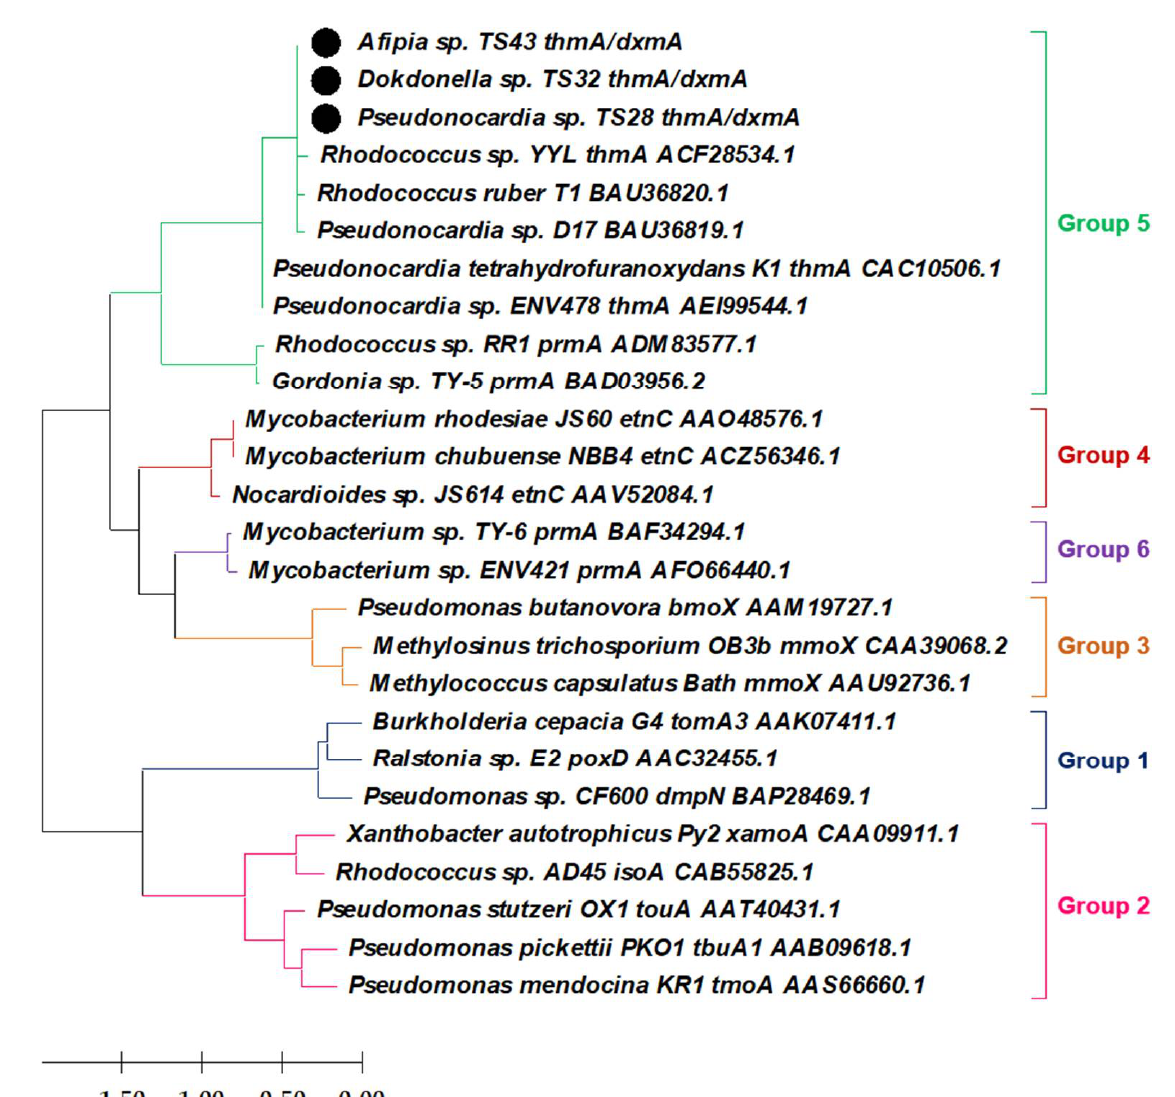
Figure 4. Phylogenetic relationships of SDIMO α -subunit genes (i.e., thmA/dxmA ) present on the chromosomes of the isolated strains (indicated by the black circles) and other SDIMO α -subunit genes as generated by the maximum likelihood method based on the alignment of amino acid se- quences.